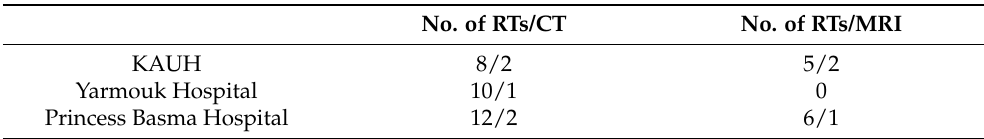
Table 1. Distribution of advanced medical imaging and the total number of RTs working on CT and MRI units at public hospitals in North Jordan Strip.